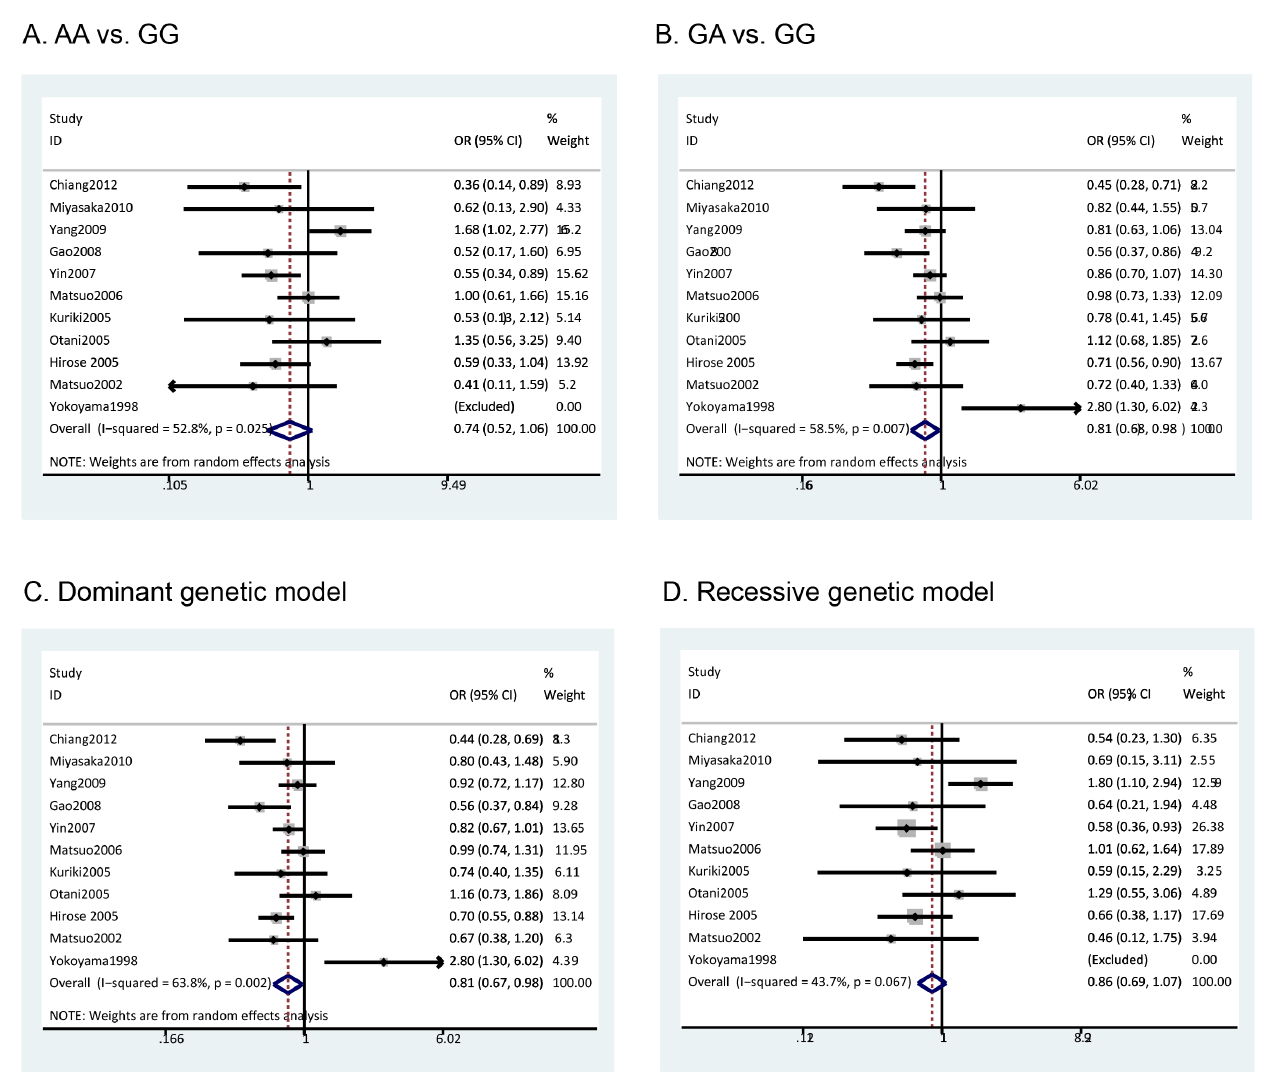
Figure 2. Meta-analysis of ALDH2 Glu487Lys polymorphism and colorectal cancer: A) AA vs. GG analysis; B) GA vs. GG analysis; C) Dominant genetic model analysis; D) Recessive genetic model analysis.